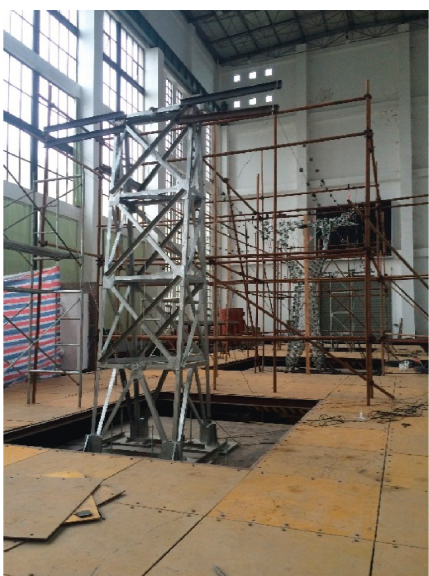
Figure 8: Physical components used for the three-tower-two-line model.